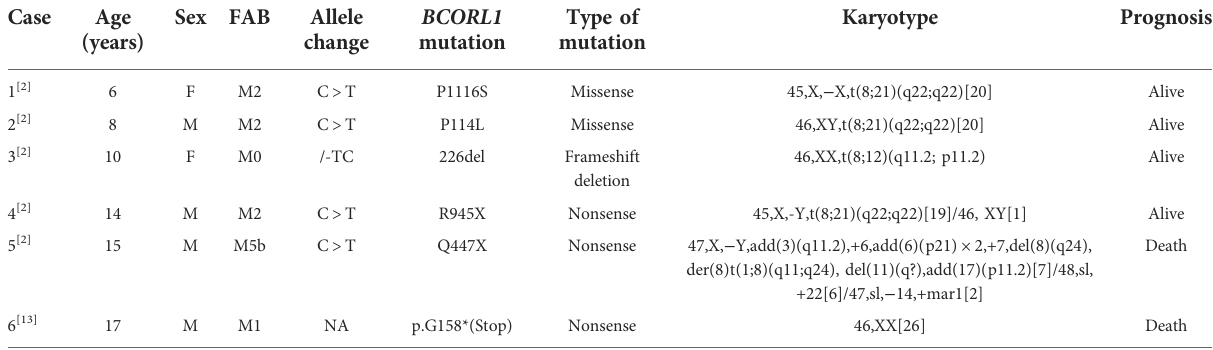
TABLE 2 Characteristics of pediatric AML with gene mutations in BCORL1